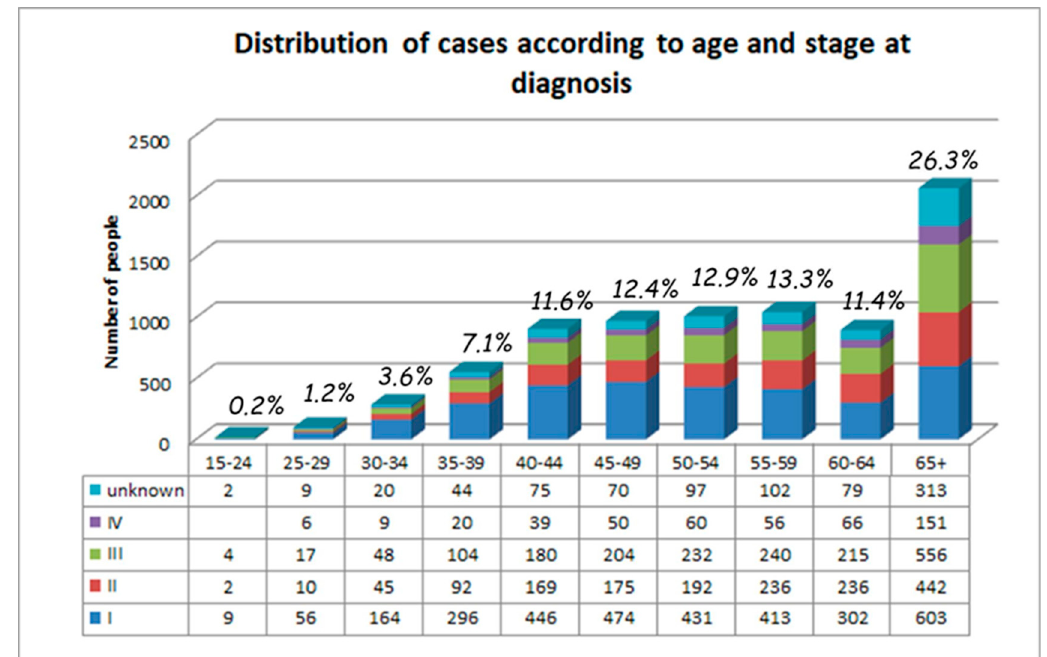
Figure 4. Distribution of CUC cases according to age and stage of diagnosis.